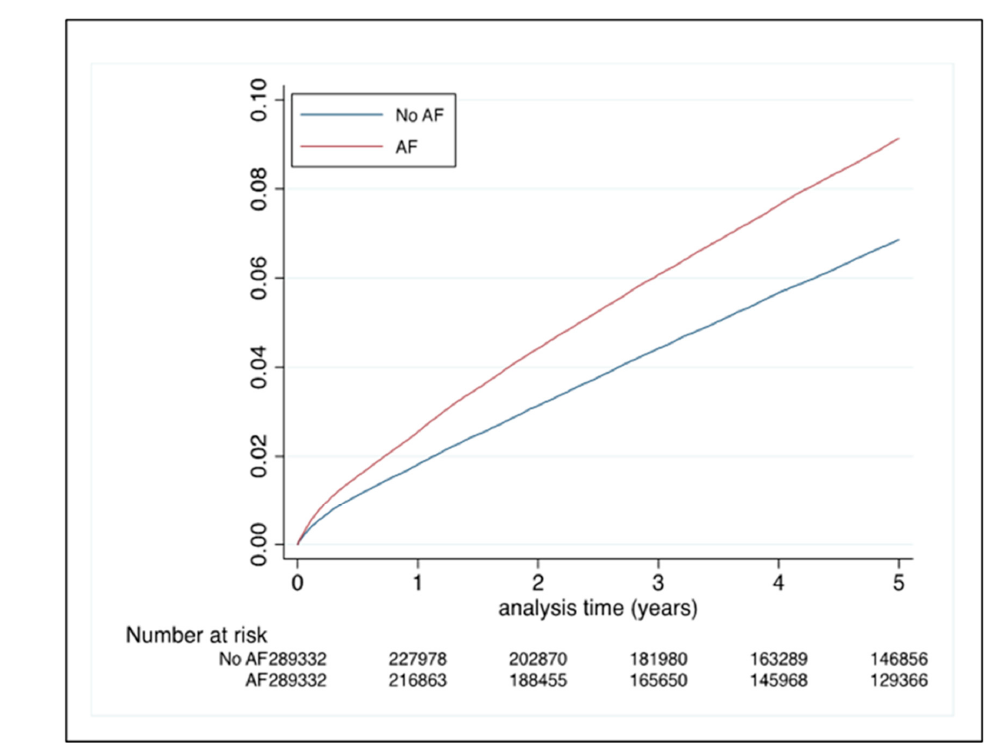
Figure 2. Incident VT/VF/CA in the matched cohorts. Abbreviations: CA—cardiac arrest, VF—ventricular fibrillation, VT—ventricular tachycardia.